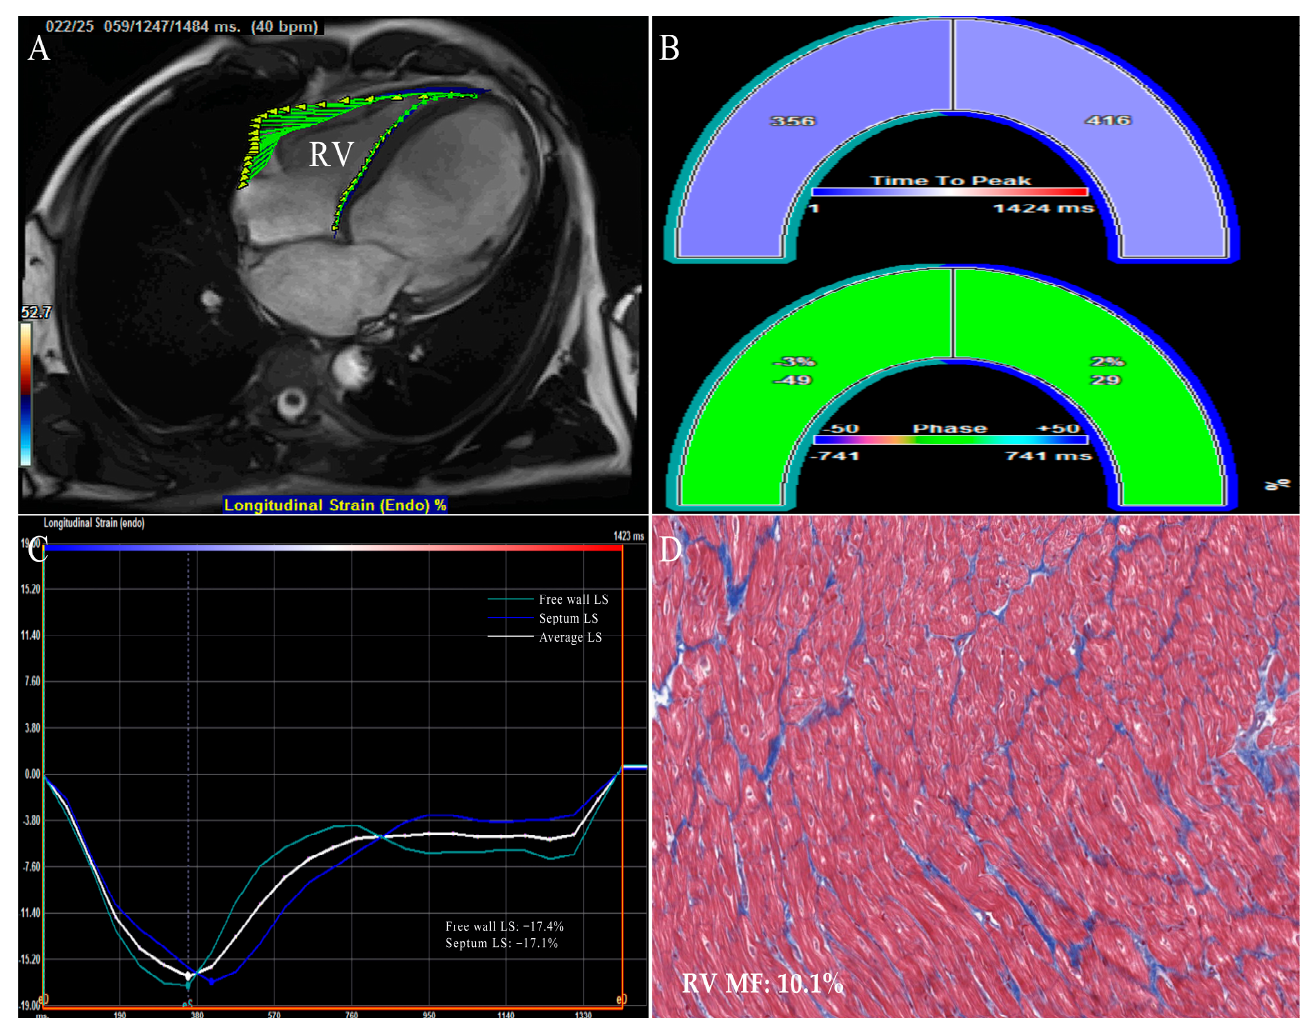
Figure 4. CMR − FT strain images of right ventricle in a DCM patient who underwent the heart transplantation. ( A ) RV endocardial border outlining and tracking. ( B ) Time to peak RV longitudinal strain and phase. ( C ) RV longitudinal strain. ( D ) Example of RV myocardial samples stained with Masson’s staining (original magnification × 200). The abbreviations as in Figures 1 −3 .